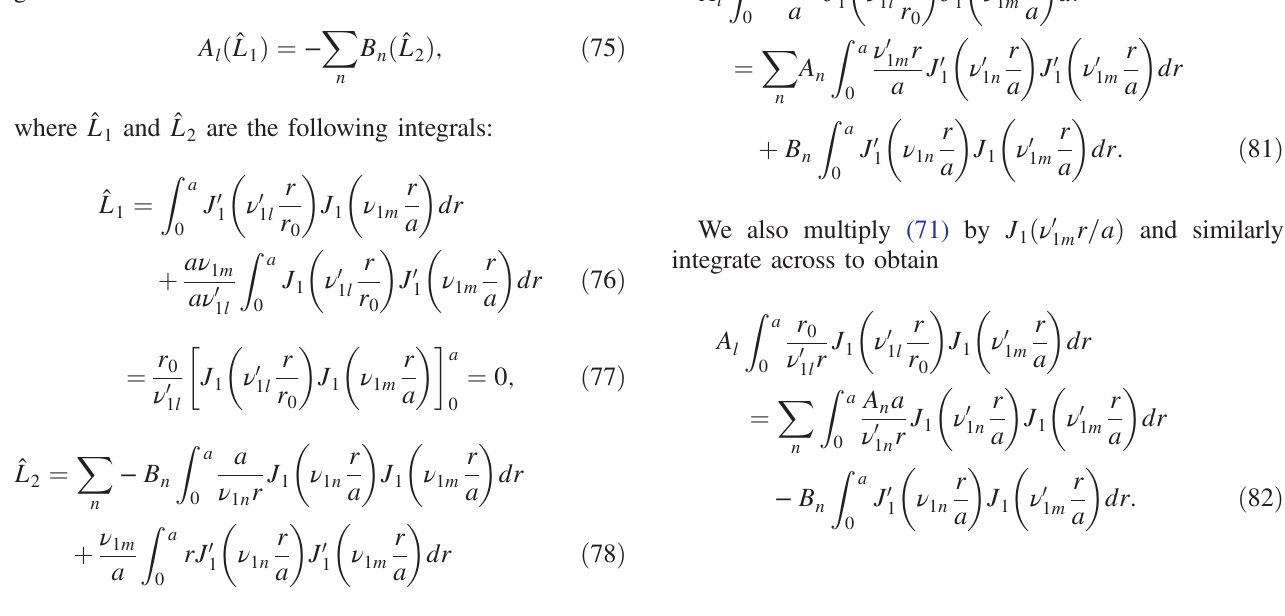
TABLE I. Summary of results for the forward-scatter expansion coefficients ð A on a step-out/in discontinuities in the oversized iris-line cell under consideration. Notice the symmetry of zeros in the table ’ s